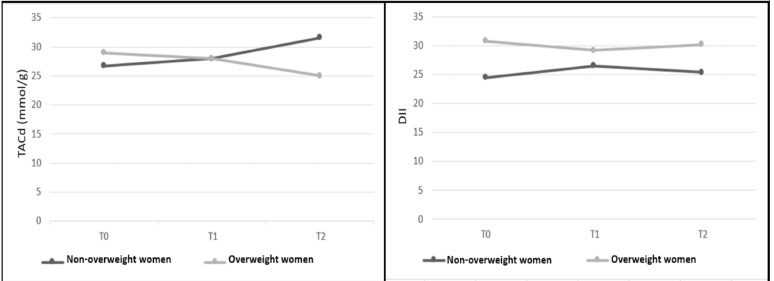
Figure 2. Association of overweight with the Total Dietary Antioxidant Capacity without coffee (TACd)